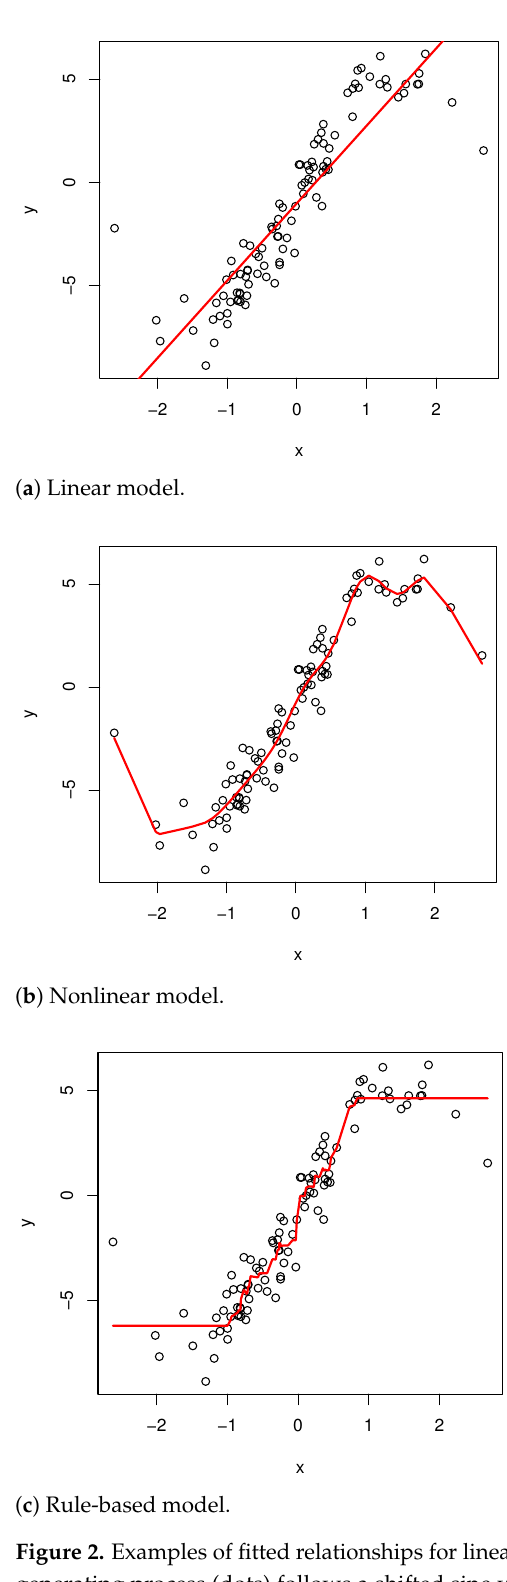
Figure 2. Examples of fitted relationships for linear, nonlinear and rule-based models. The true data generating process (dots) follows a shifted sine wave with Gaussian noise. Panel a represents the fit obtained by a linear regression. Panel b represents the fit obtained by support vector regression. Panel c represents the fit obtained by boosted trees with stochastic gradient